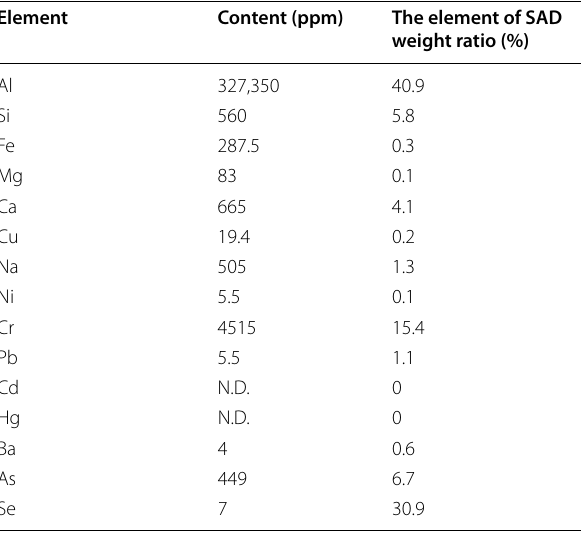
mg kg − 1 Table 3 Total element analysis of the product (mg kg − 1 =